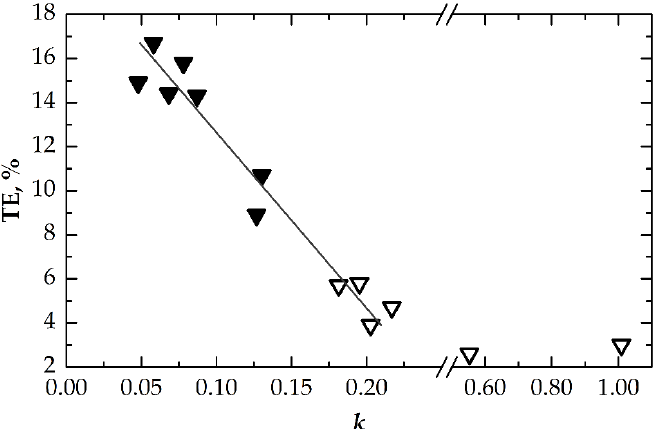
Figure 3. Tensile elongation as a function of the value of k for all conditions investigated. Hollow symbols are for brittle ruptures; full symbols are for ductile ruptures.